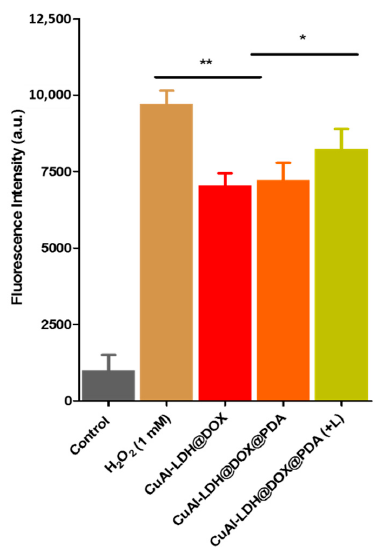
Figure 5. In vitro cell viability studies, dose-dependent cell viability of A549 cells incubated with